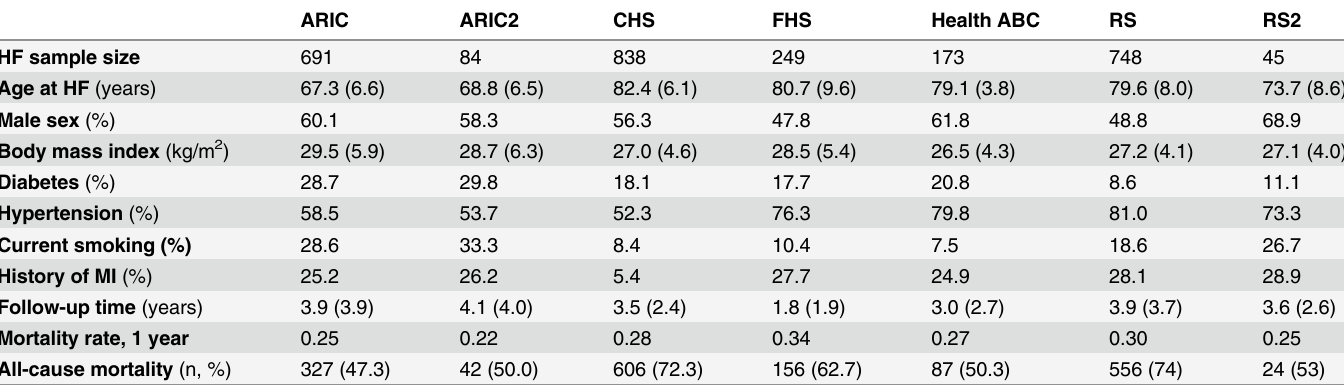
Table 1. Characteristics of cohorts in stage 1.